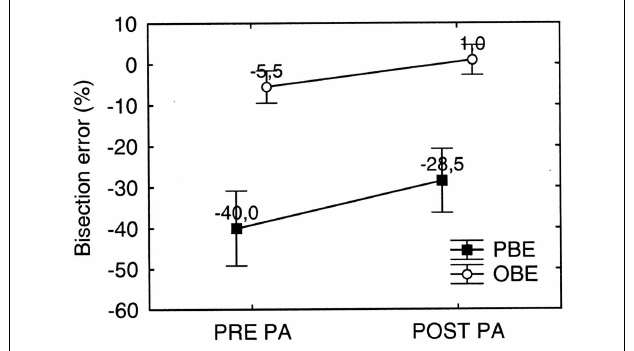
FIGURE 10 | Graphic representation of the overall effect of prismatic adaptation (PA) on MR’s bisection by walking error in far space . PA is effective in significantly reducing both the observed (OBE) and the predicted (PBE) bisection error. PBE is significantly larger than OBE, but error reduction due to PA is comparable. Error bars represent standard errors. Bisection error is expressed as % deviation with respect to half line length. Negative and positive values indicate errors to the left and to the right of the objective midline, respectively. See text for details.